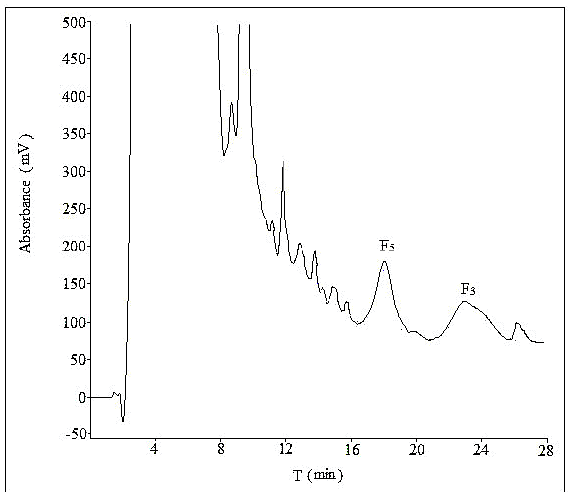
Figure 7. The semi-preparative chromatogram of CEFBPG with the mobile phase of acetonitrile:water (32:68) at room temperature and a flow rate of 10 mL/min.